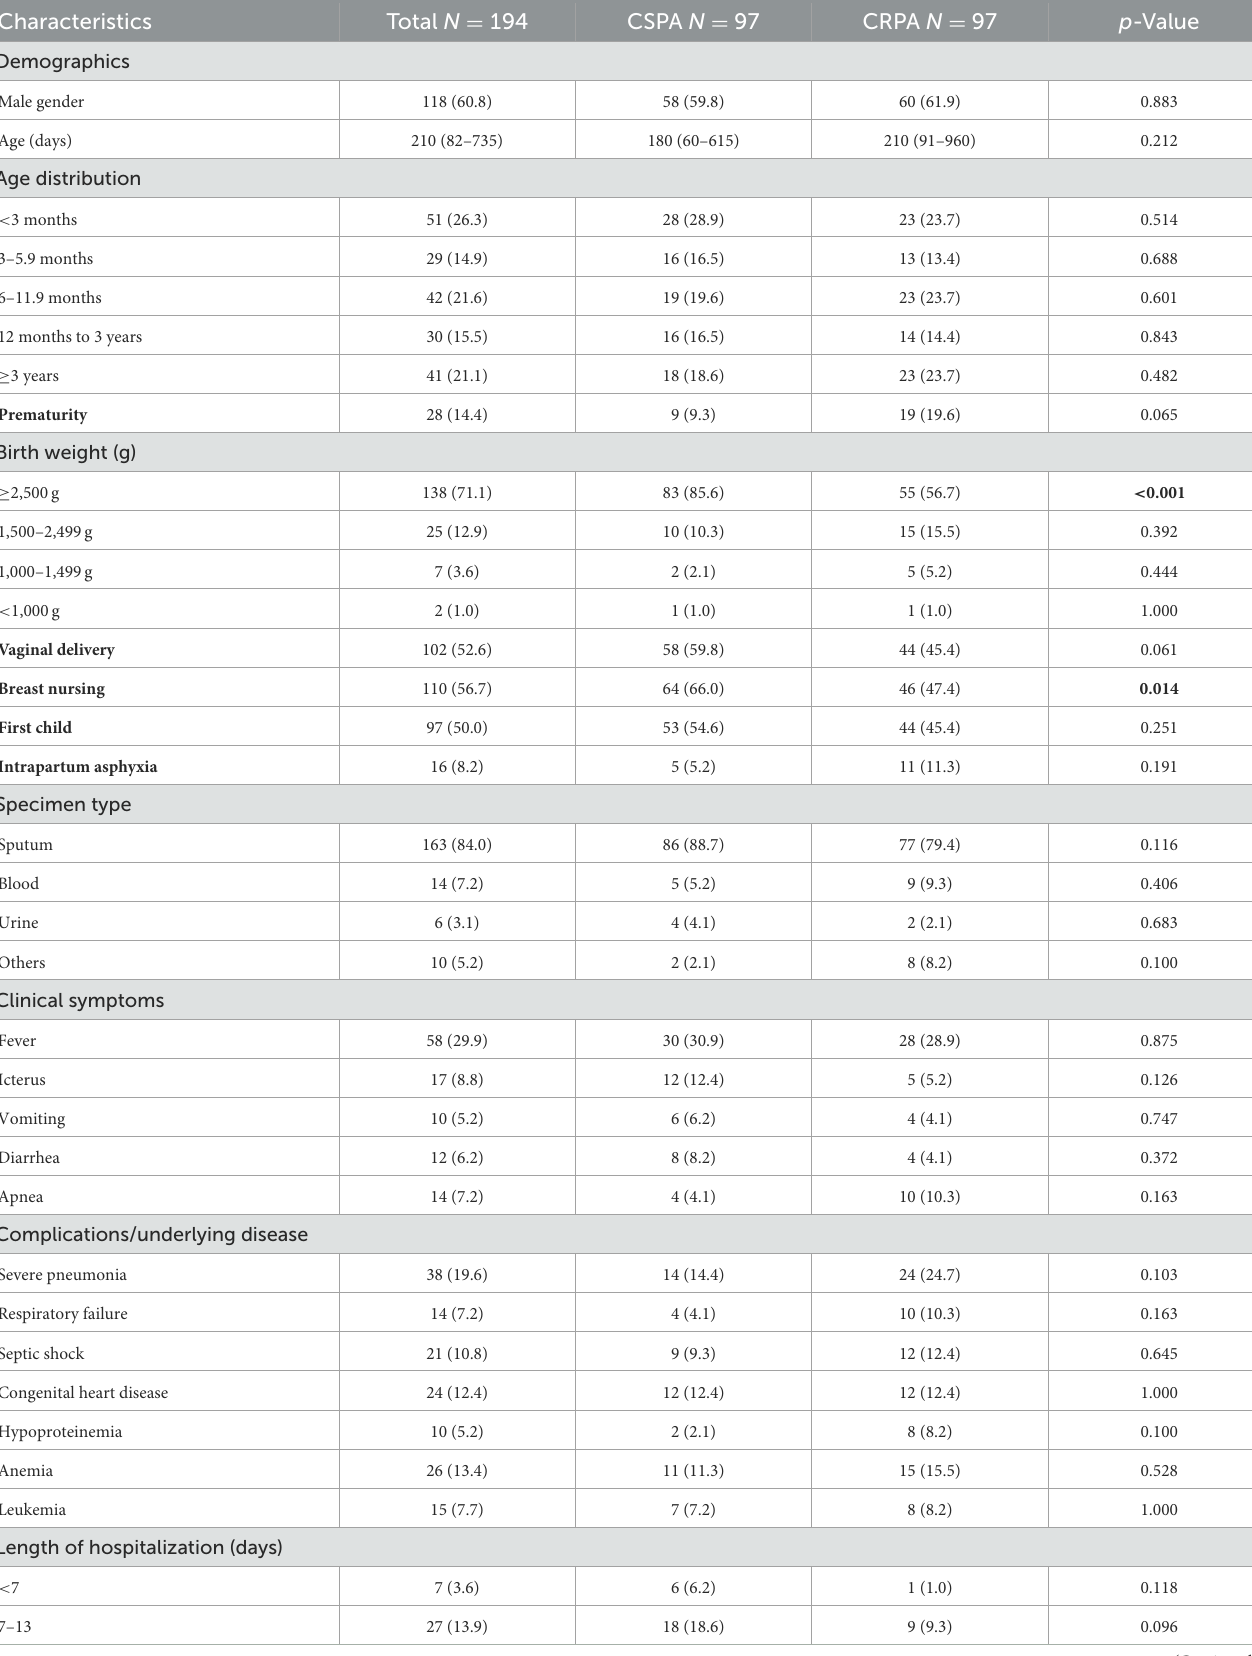
TABLE 2 Baseline and clinical characteristics of 194 hospitalized children with Pseudomonas aeruginosa infections.